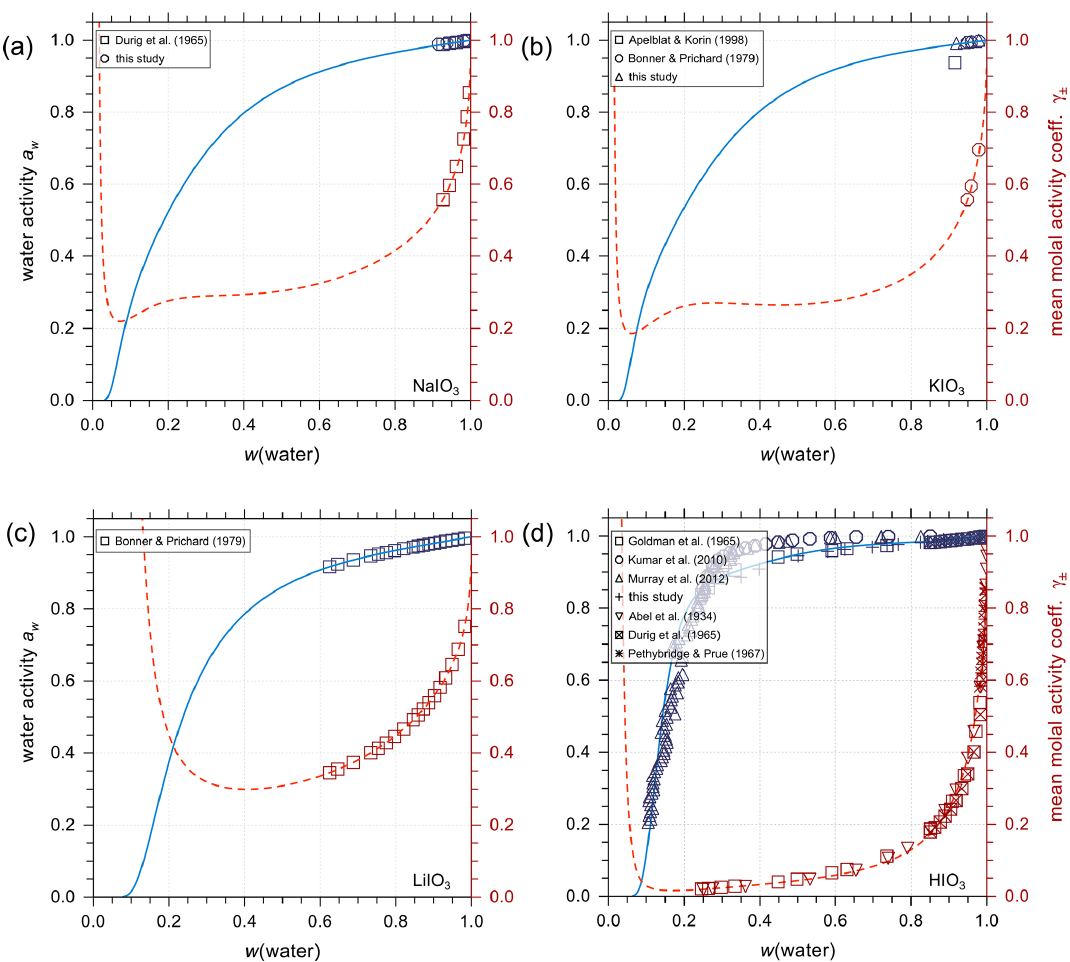
Figure 3. Water activities and mean molal ion activity coefficients of the electrolytes in binary aqueous iodate solutions at room temperature. Symbols: experimental data (see legend); solid blue and dashed red curves: fitted AIOMFAC model. (a) NaIO 3 , (b) KIO 3 , (c) LiIO 3 , and (d) HIO 3